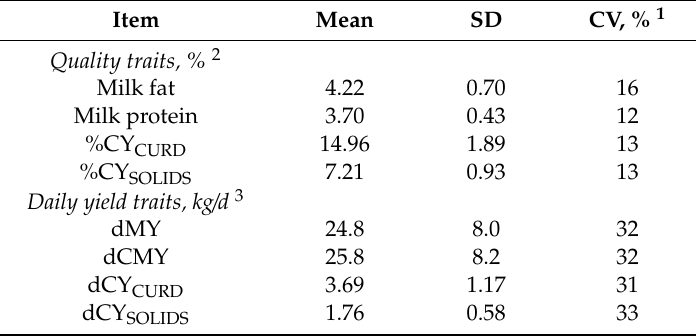
Table 1. Descriptive statistics for the milk quality and daily yield